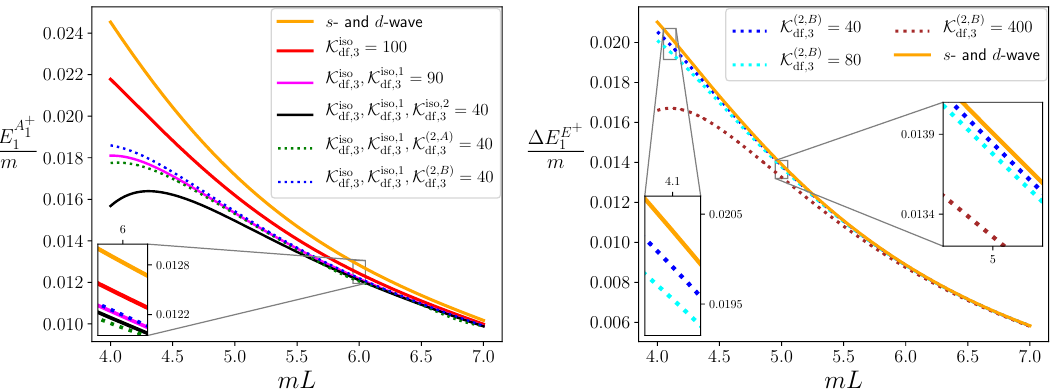
Figure 7. Energy shift of the (cid:12)rst excited state in the A + ious choices of the parameters in for all curves. The choices of that a parameter value not given explicitly is set to the value given earlier. For example, the black line has the parameters set to